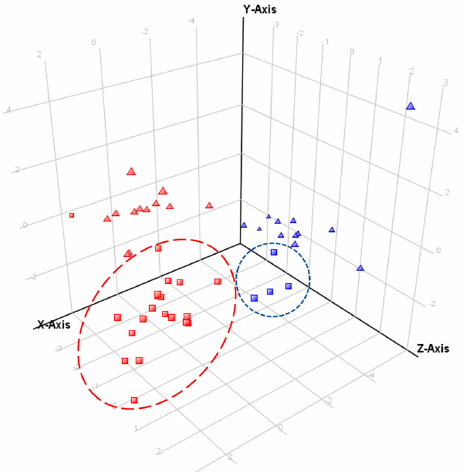
Figure 7. Principal component analysis (PCA) of samples of both species from the field experiment and controlled conditions experiment. PCA included 17 PANOs and growth stage as independent variable. Component 1, 2 and 3 contribute to separation by 41.83%, 11.58% and 9.75%, respectively. Discriminating metabolites for component 1 (PCA loadings ≥ 0.3): 5, 6, 17 and for component 2 (PCA loadings > 0.4): 1. Key to symbols: Echium plantagineum , red; E. vulgare , blue; field survey samples, squares; glasshouse samples, triangles. Outlying field sample of E. plantagineum was collected in Silverton (Table S2).